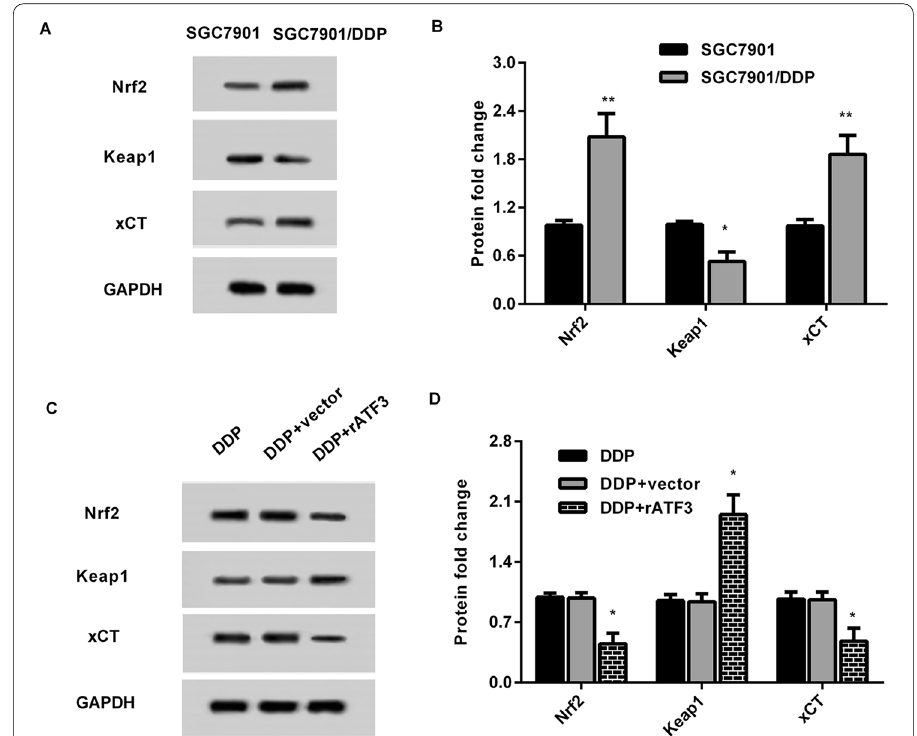
Fig. 5 Up-regulation of ATF3 restrained the activation of Nrf2/Keap1/xCT signaling in SGC7901/DDP cells. A , B Protein expression of Nrf2, Keap1 and xCT was analyzed in SGC7901 and SGC7901/DDP cells. Image J software was used to quantify the density of the bands. C , D After transfection with ATF3 plasmids, activation of Nrf2/Keap1/xCT signaling was detected in SGC7901/DDP cells under cisplatin conditions. * P < 0.05. ** P <